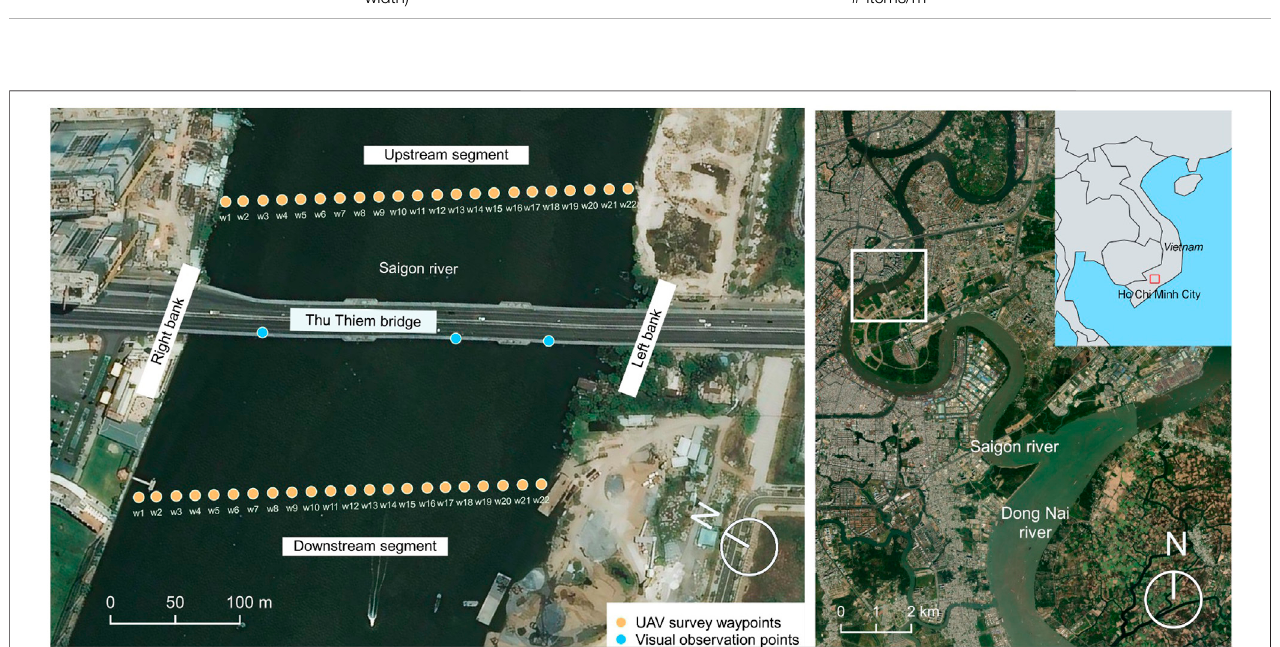
FIGURE 1 | Localization of visual observation points and 22 Unmanned aerial vehicle survey waypoints. Right and left river banks refer to the hand sides when facing downstream. Source: Bing imagery.